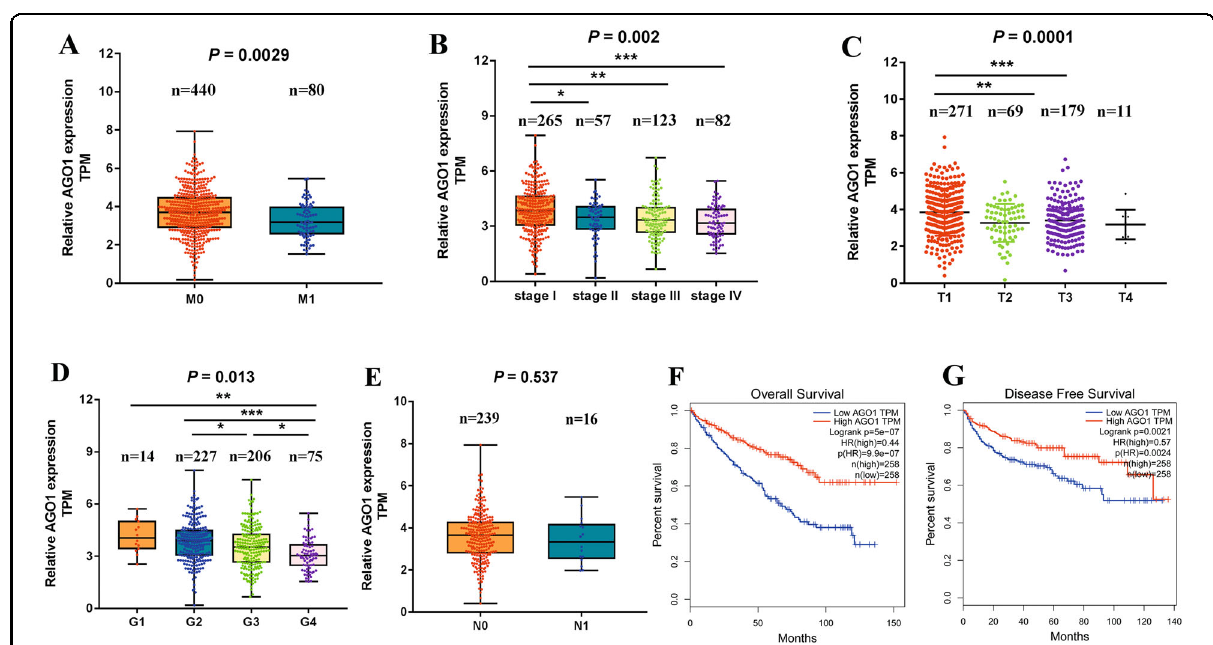
Fig. 5 AGO1 is closely related to favorable clinical features and prognosis. A – E Correlation of AGO1 with clinicopathological characteristics in patients with ccRCC, including metastasis ( A ), TNM stage ( B ), T stage ( C ), histologic grade ( D ), and lymph node metastasis ( E ). Horizontal lines in the boxes in A , B , D , E indicated the median value. Boxes spanned the interquartile range. Whiskers extended from the minimum to the maximum. Horizontal lines in C represent the mean value. F , G Kaplan – Meier analysis of overall survival ( F ) and disease-free survival ( G ) regarding AGO1 expression in ccRCC patients. * P < 0.05, ** P < 0.01, *** P <